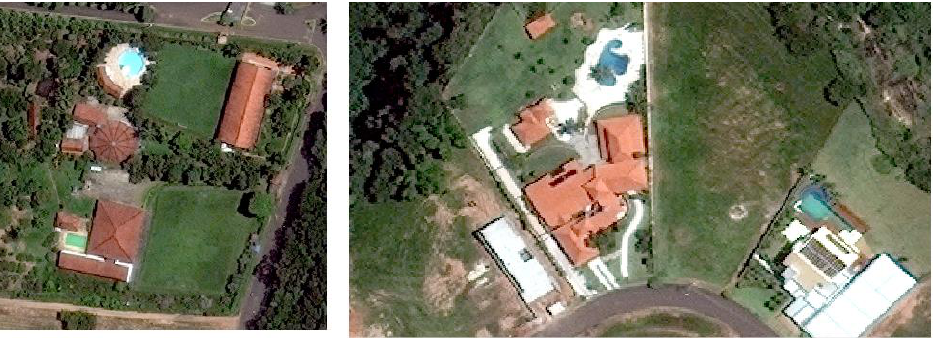
Figure 12. Illustration of the correlation between leisure areas with pools and herbaceous and arboreal vegetation. WorldView II Image—Garden Park Condominium.